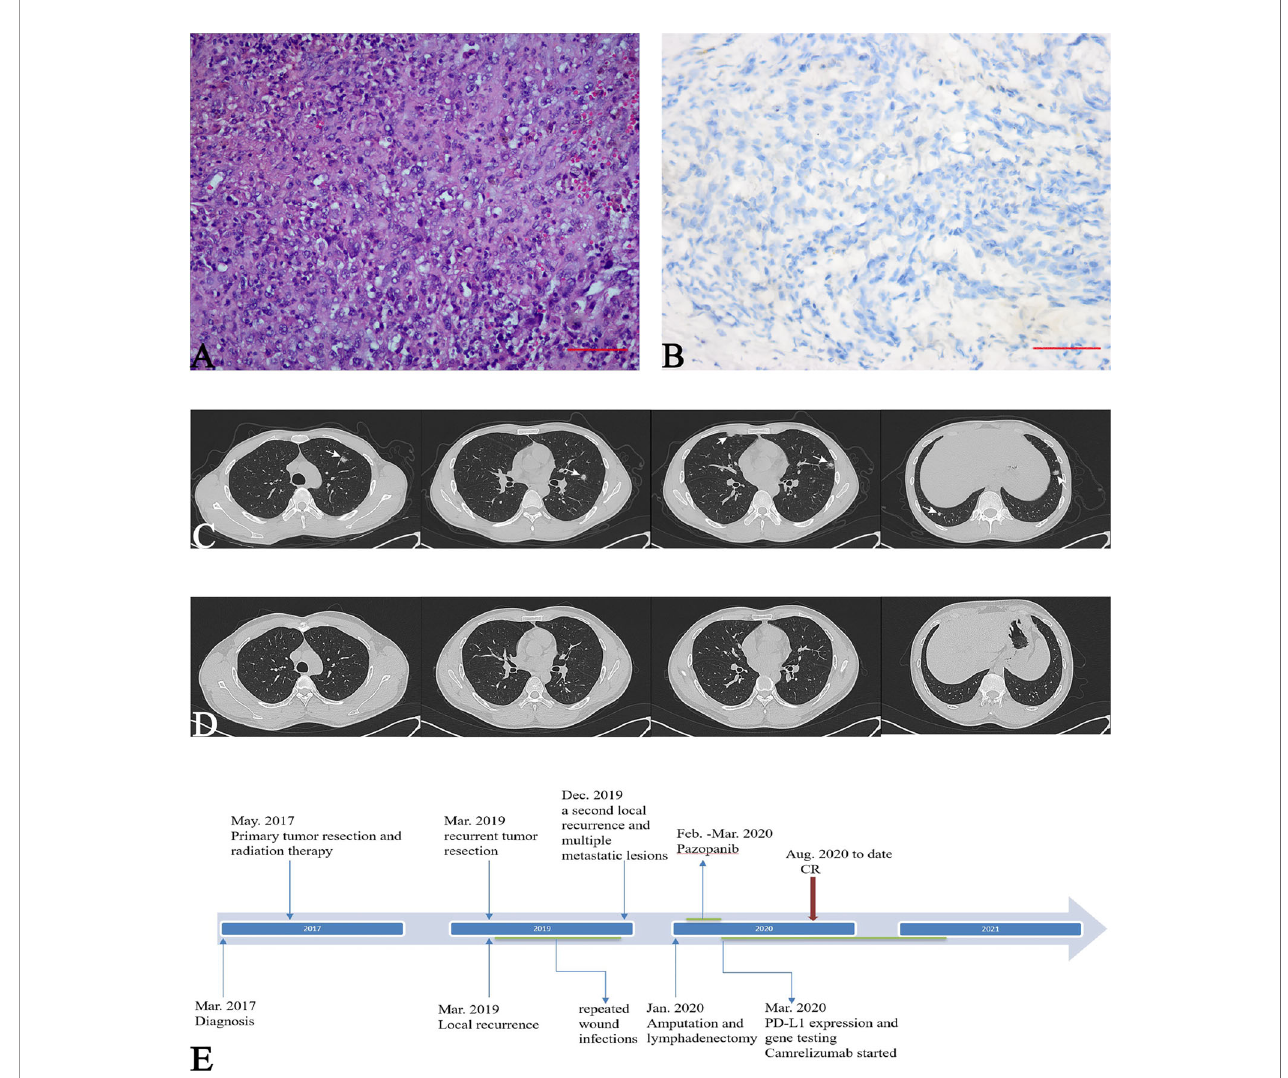
FIGURE 2 | Pathological features of the local lesions. (A) Sheets of epithelioid and spindle-shaped large atypical cells and moderate nuclear pleomorphism (Haematoxylin and eosin stain, 200×); CT of the chest, (B) Immunohistochemical loss of integrase interactor 1 (INI-1) (400×); (C) white arrows indicate multiple pulmonary metastases (D) fi ve months after camrelizumab therapy, pulmonary metastases completely disappeared; (E) Timeline of treatments from diagnosis to